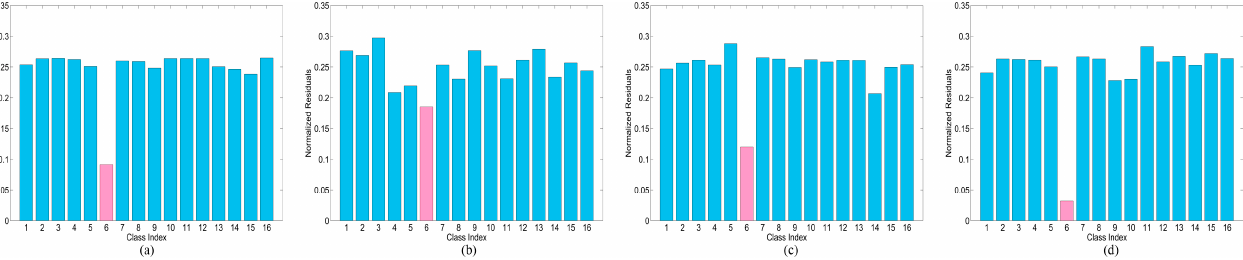
Figure 13. Reconstruction residuals of a test sample from class 6 in the Indian Pines data set using 10 training samples per class for the MFCART algorithm. ( a ) Spectral. ( b ) Gabor. ( c ) DMP. ( d ) LBP.